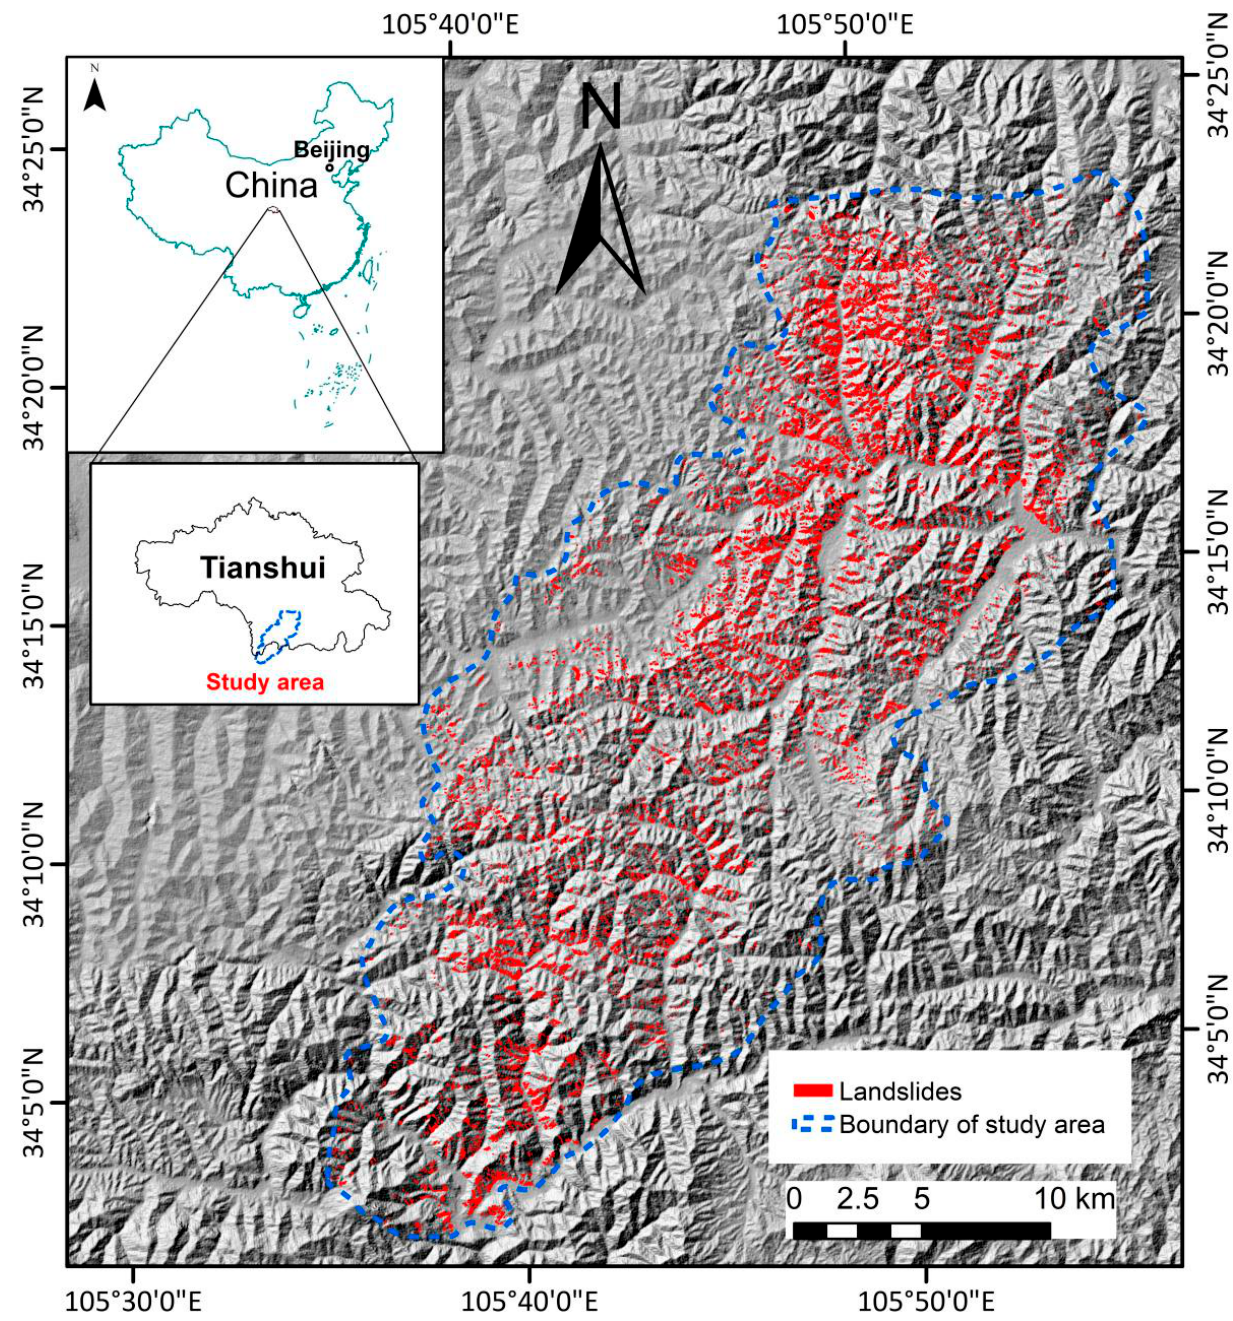
Figure 1. Location of the study area and landslide inventory map.